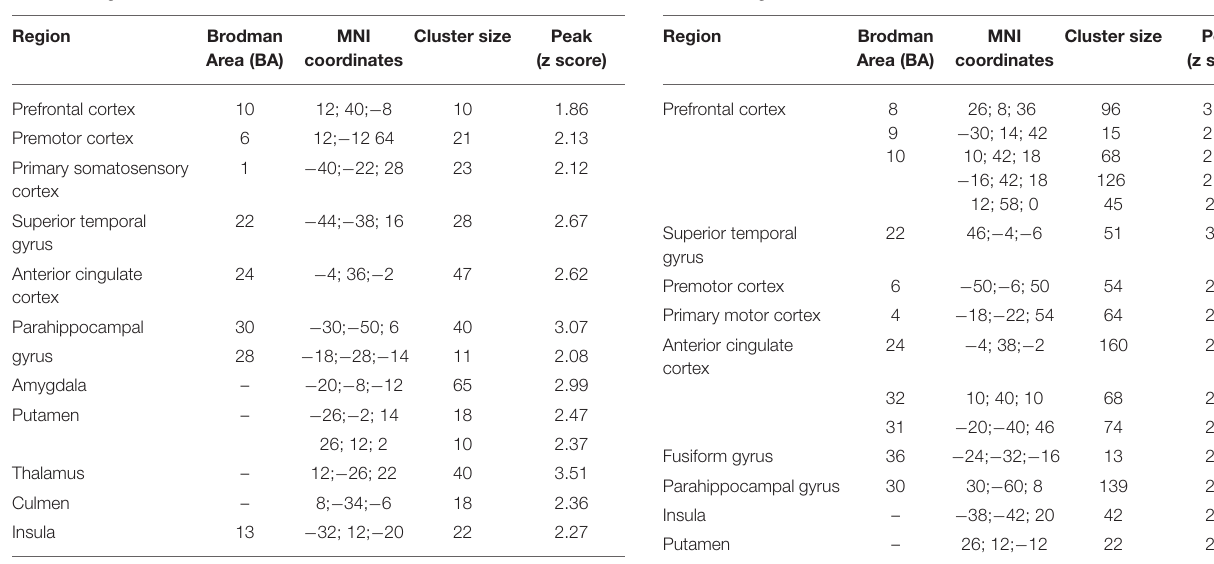
TABLE 3.3 | Main foci of activation for second person sentences in INS condition contrasted against RW.